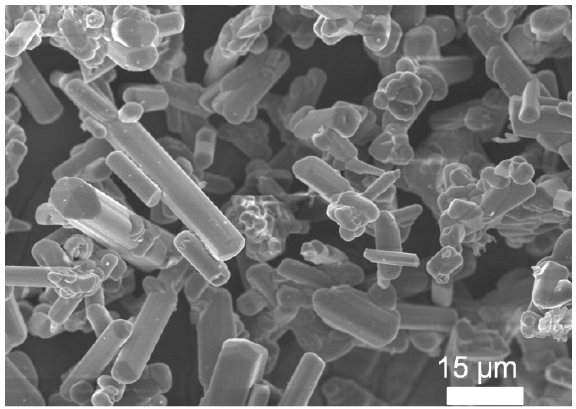
Figure 9. Particle morphology of the as-received β -sialon:Eu 2+